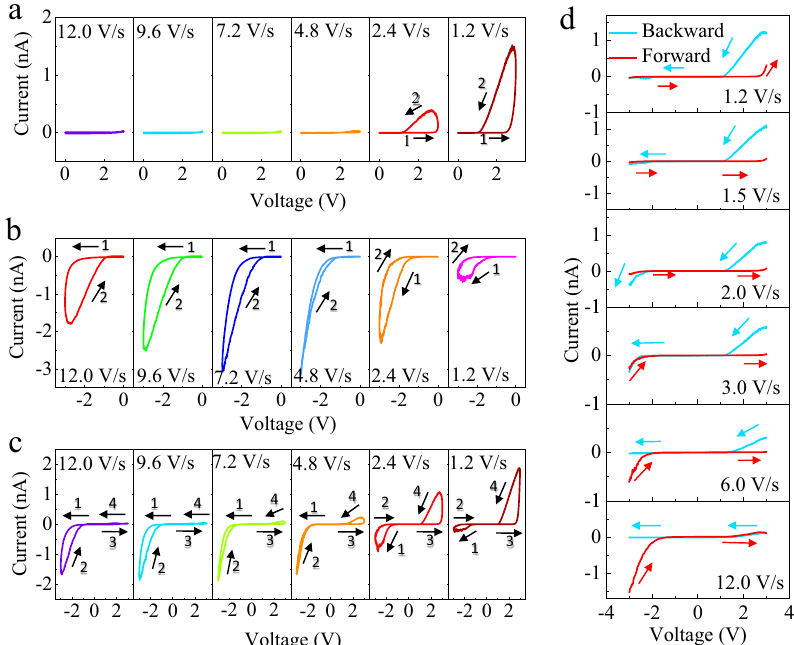
Fig. 2 Current recti fi cation modulated by the sweeping speed/direction. a – c Response of current – voltage ( I – V ) curves to sweeping speed with a sinusoidal voltage sweeping semi-cycle of (0 V → + 3 V → 0 V), (0 V → − 3 V → 0 V), and full-cycle of (0 V → − 3 V → + 3 V → 0 V), respectively; I – V curves are consecutively measured at a gradually lower sweeping speed ranging from 12.0 V/s to 1.2 V/s. The numbers 1-4 denote the sweeping sequence. d Response of I – V curves measured by the forward voltage sweeping ( − 3 V → + 3 V) and backward voltage sweeping ( + 3 V → − 3 V) at a different sweeping speeds ranging from 12.0 V/s to 1.2 V/s on two adjacent